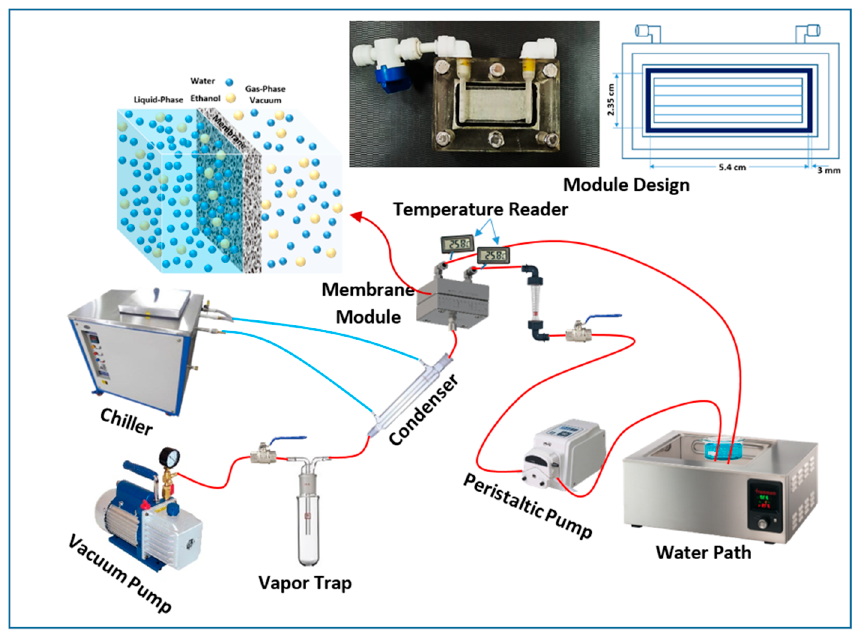
Figure 1. Schematic diagram of the vacuum membrane distillation setup and module design.